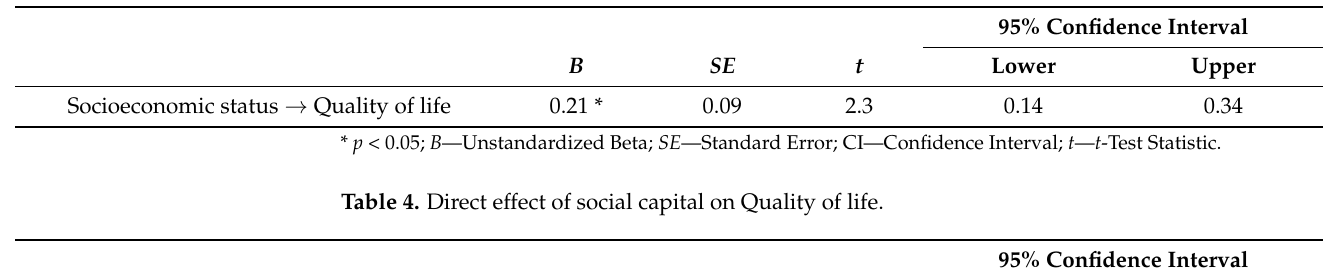
Table 3. Direct effect of socioeconomic status on Quality of life.